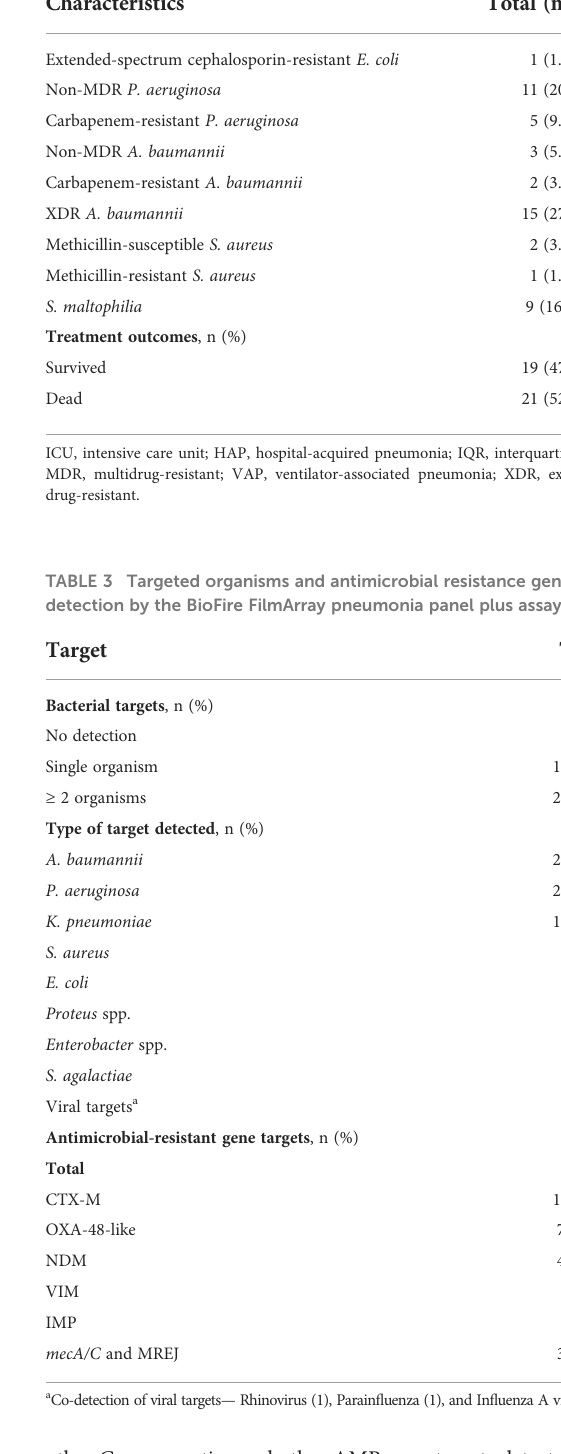
0.57). Of the 16 P . aeruginosa , seven strains had non-MDR